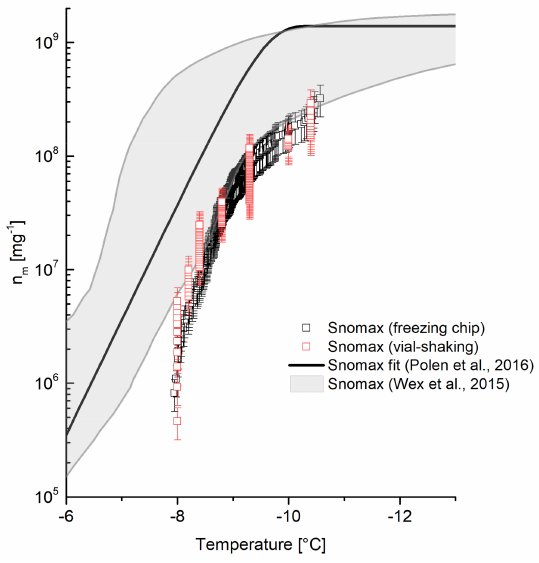
Figure 8. The n m values of Snomax determined with the freezing chip compared to measurements performed with the vial-shaking technique and already published data [19,36]. The error bars of the n m values originate from the estimation of the corresponding droplet diameter of 40 µ m ± 10% and weighing